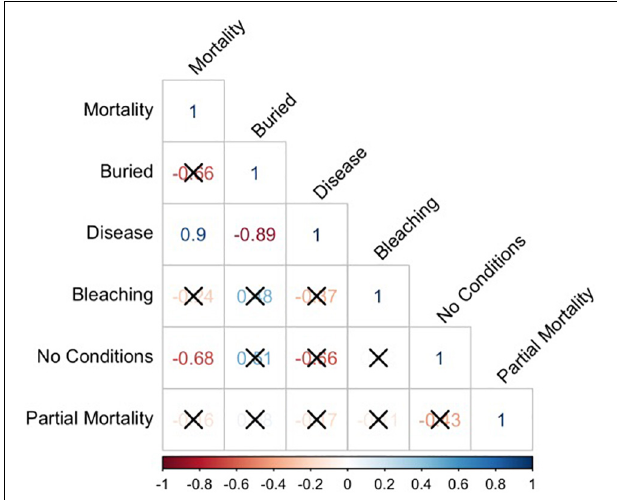
FIGURE 8 | Pairwise correlation plots comparing mortality, burial, disease, bleaching, no conditions and partial mortality for the nine most abundant coral species – Pseudodiploria clivosa (PCLI), Dichocoenia stokesi (DSTO), Psuedodiploria strigosa (PSTR), Montastrea cavernosa (MCAV), Meandrina meandrites (MMEA), Porites astreoides (PAST), Solenastrea bournoni (SBOU), Stephanocoenia intercepta (SINT), and Siderastrea siderea (SSID). Pearson correlation ( r -value) is shown with significant values ( p < 0.05) shown in bold and colored by strength (blue for highest positive correlation and red for lowest negative correlation). Non-significant correlations are crossed out in the